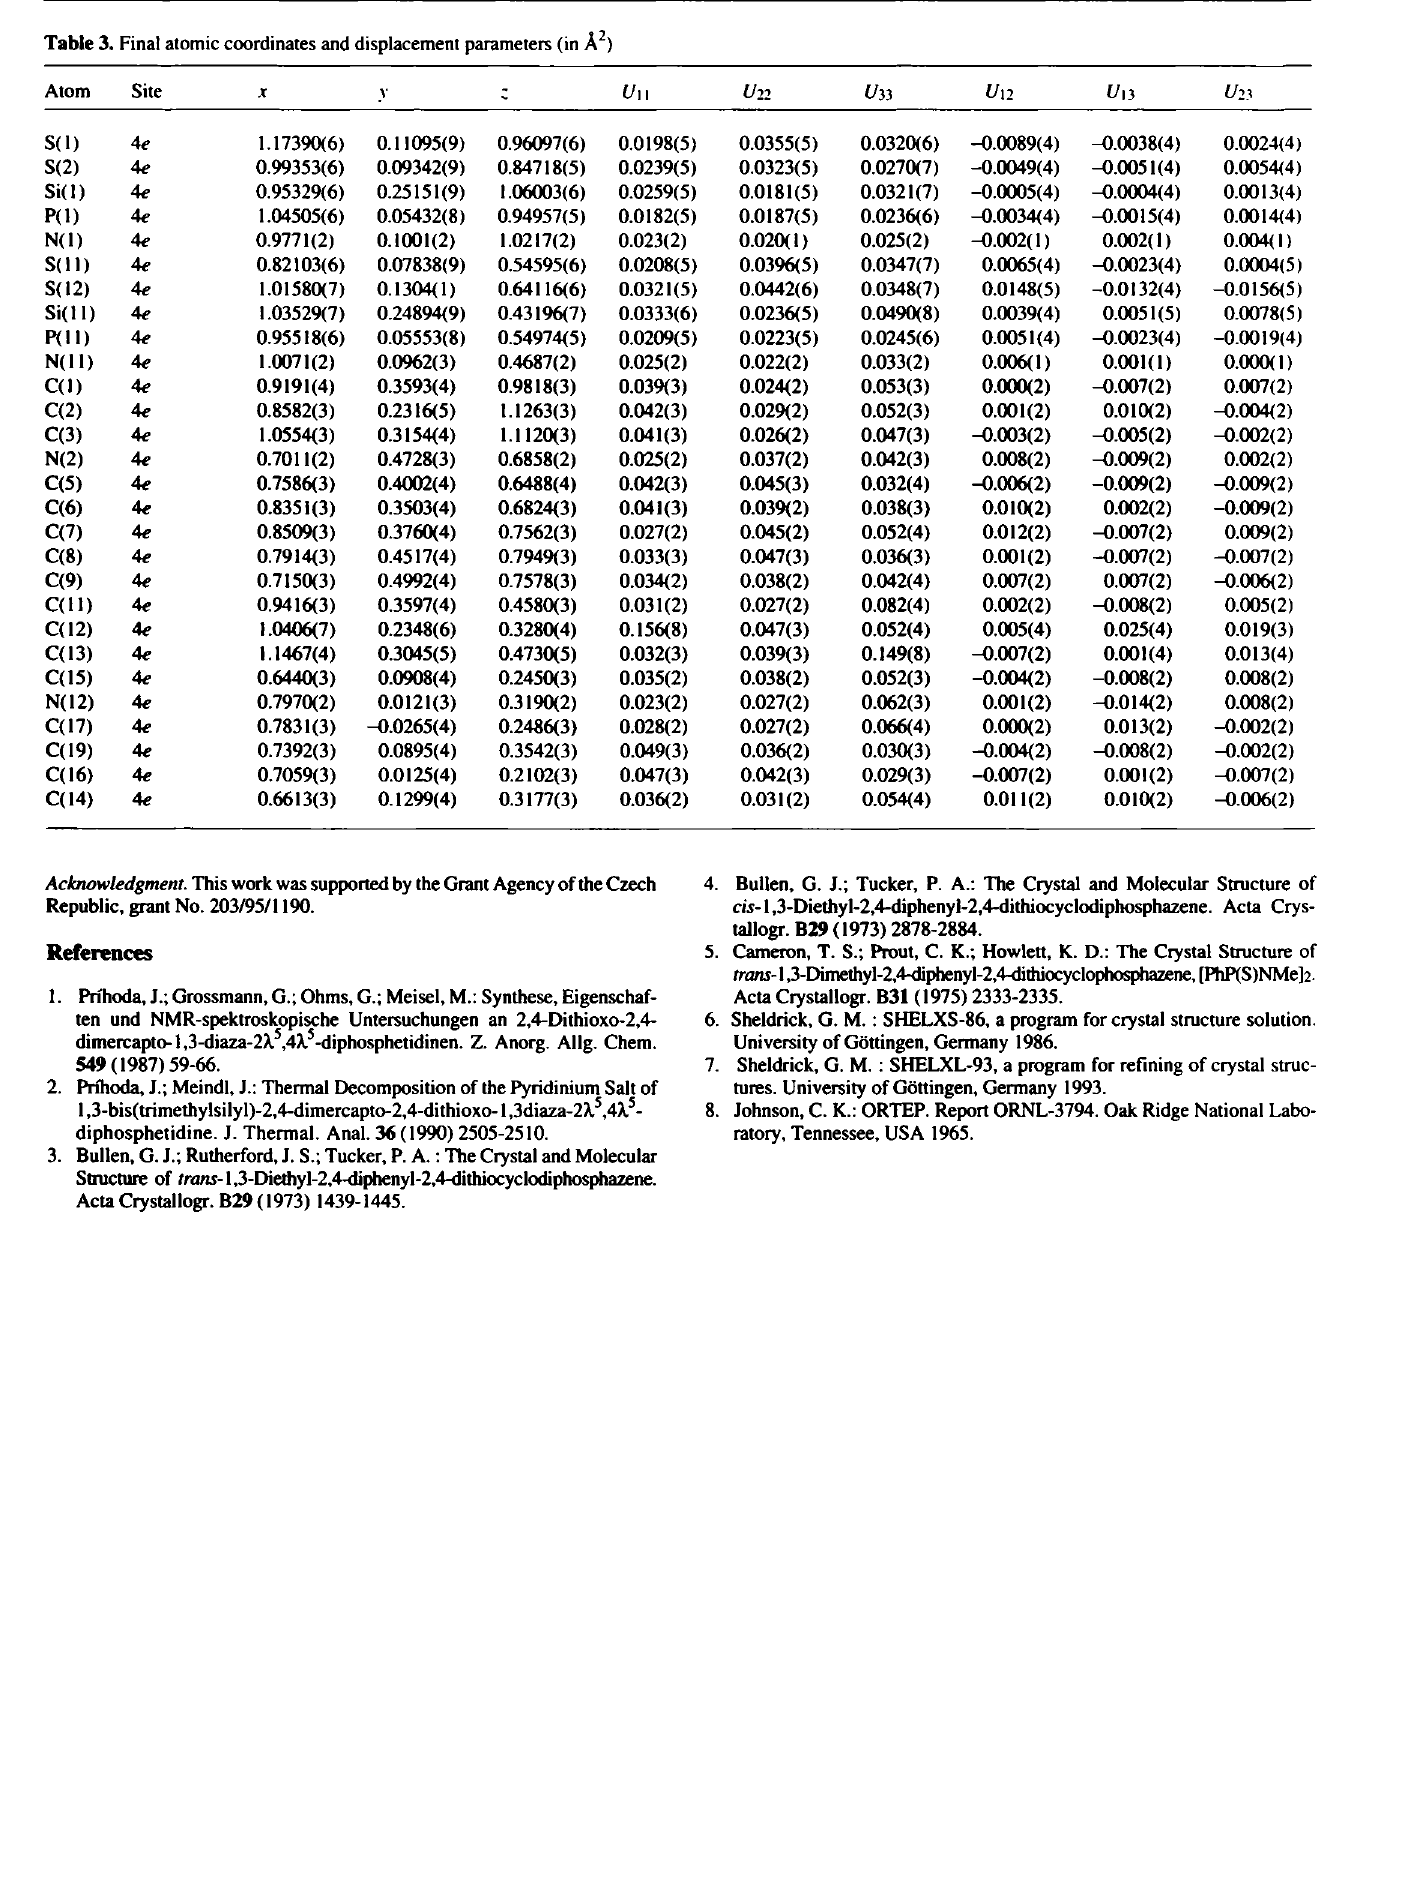
Table 3. Final atomic coordinates and displacement parameters (in Â 2